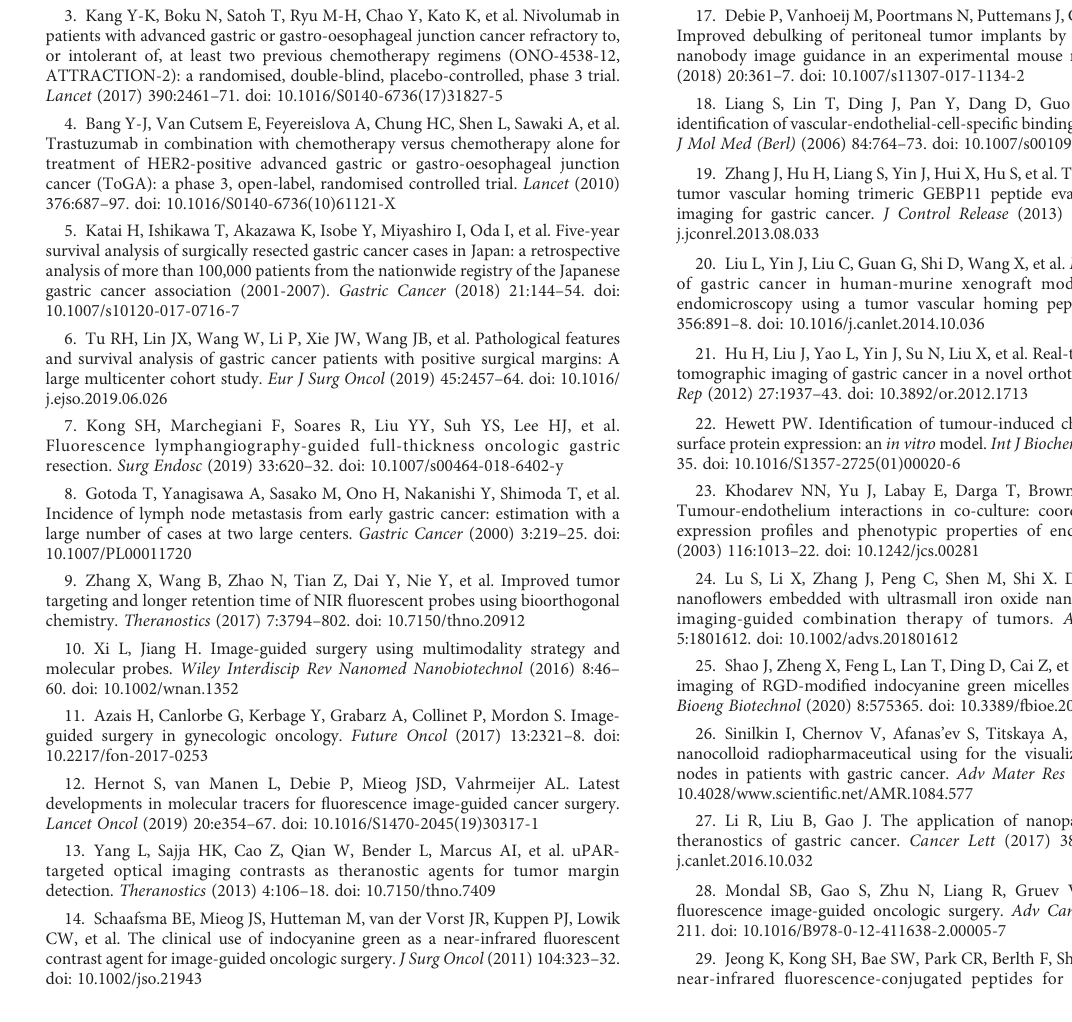
SUPPLEMENTARY FIGURE 1 Chemical structure and MS identi fi cation of Cy 5.5 labeled